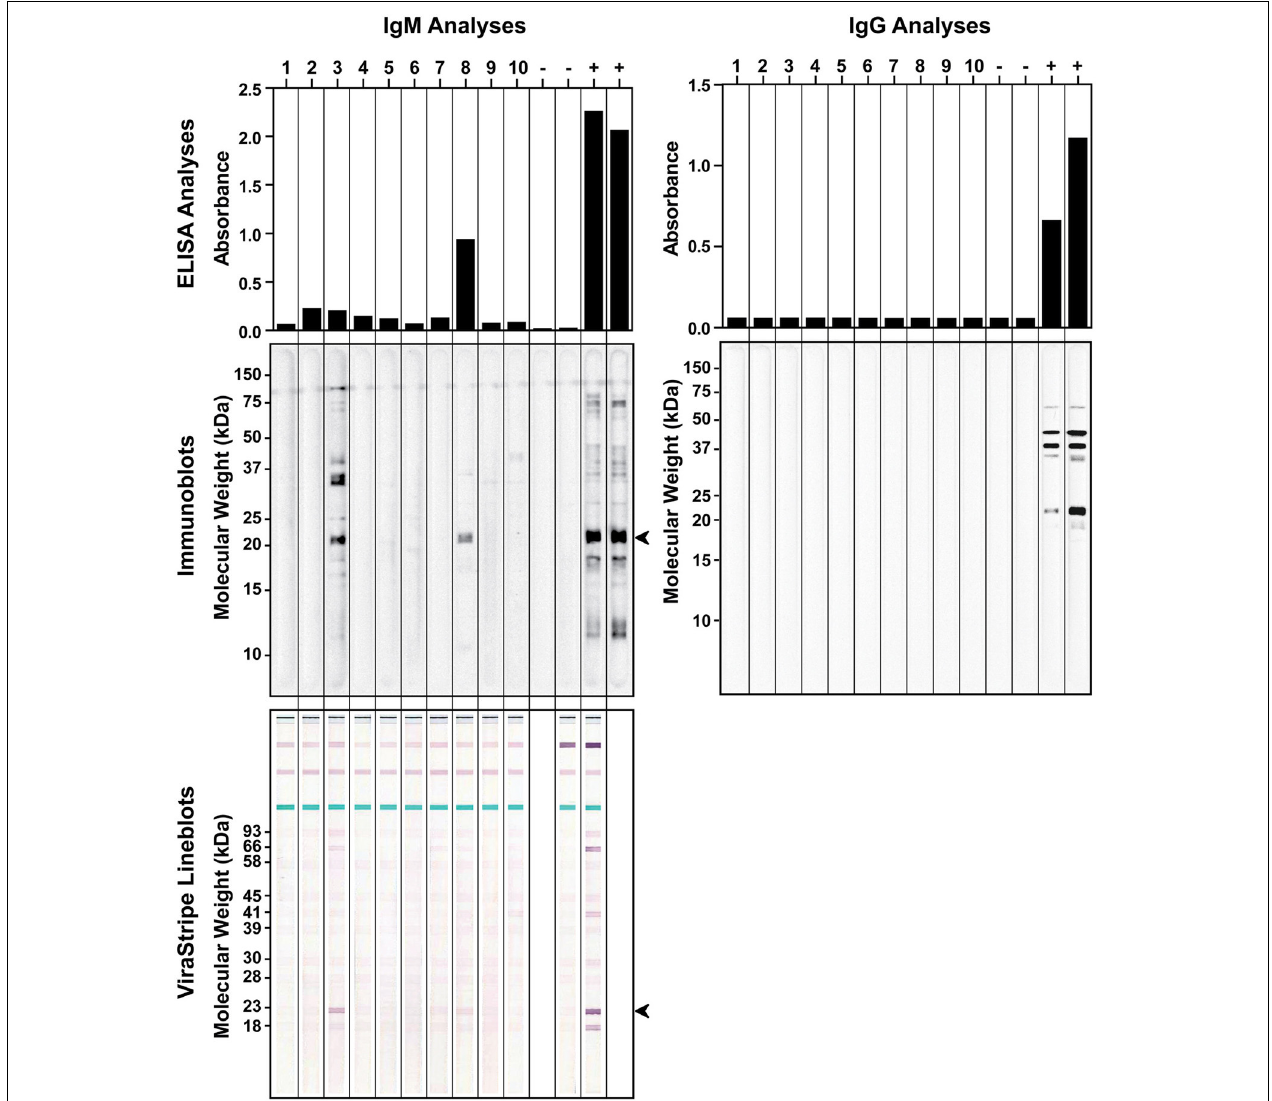
FIGURE 4 | Detection of antibodies to B. burgdorferi antigens in field-captured P. leucopus from Tiverton Township. ELISA (top panels) and immunoblot (middle panels) analyses of IgM (left panels) and IgG (right panels) responses to B. burgdorferi whole-cell lysate were shown for serum samples